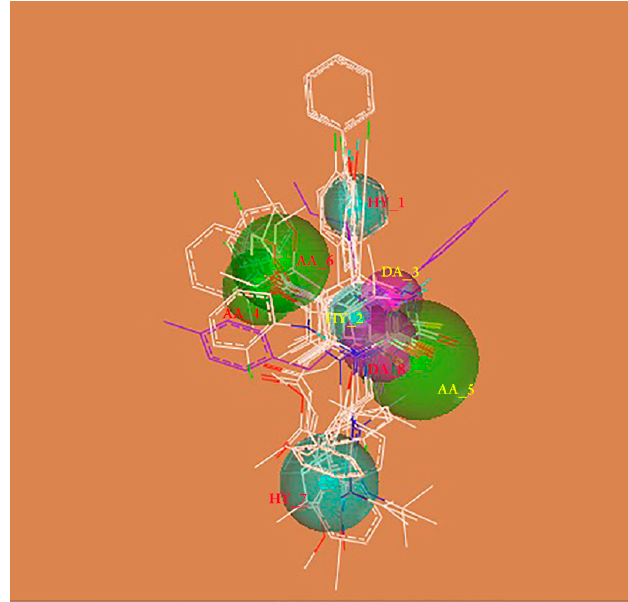
Figure 3. Pharmacophore Requirements.